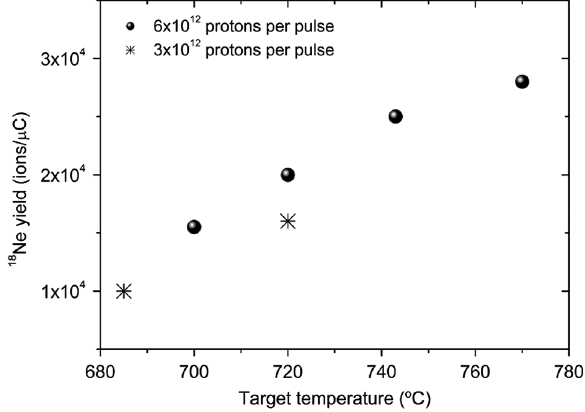
FIG. 7. Experimentally measured yields for different target temperatures and different proton beam